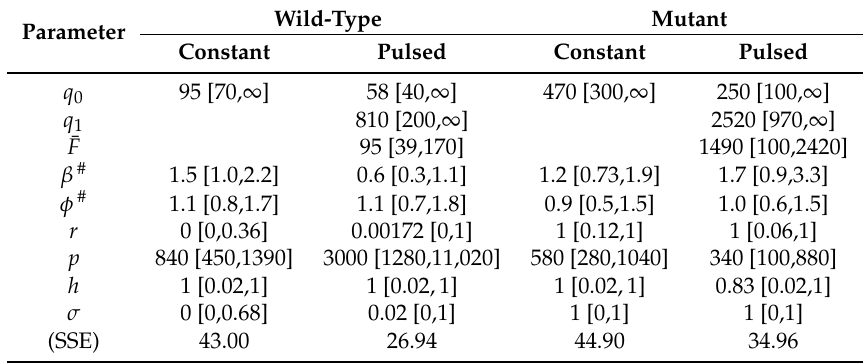
Table 6. Fitted parameters for the Schmid et al. wild-type and mutant datasets under constant and pulsed secretion rate models. IFN and viral units are in terms of pg/mL and a.u./mL,